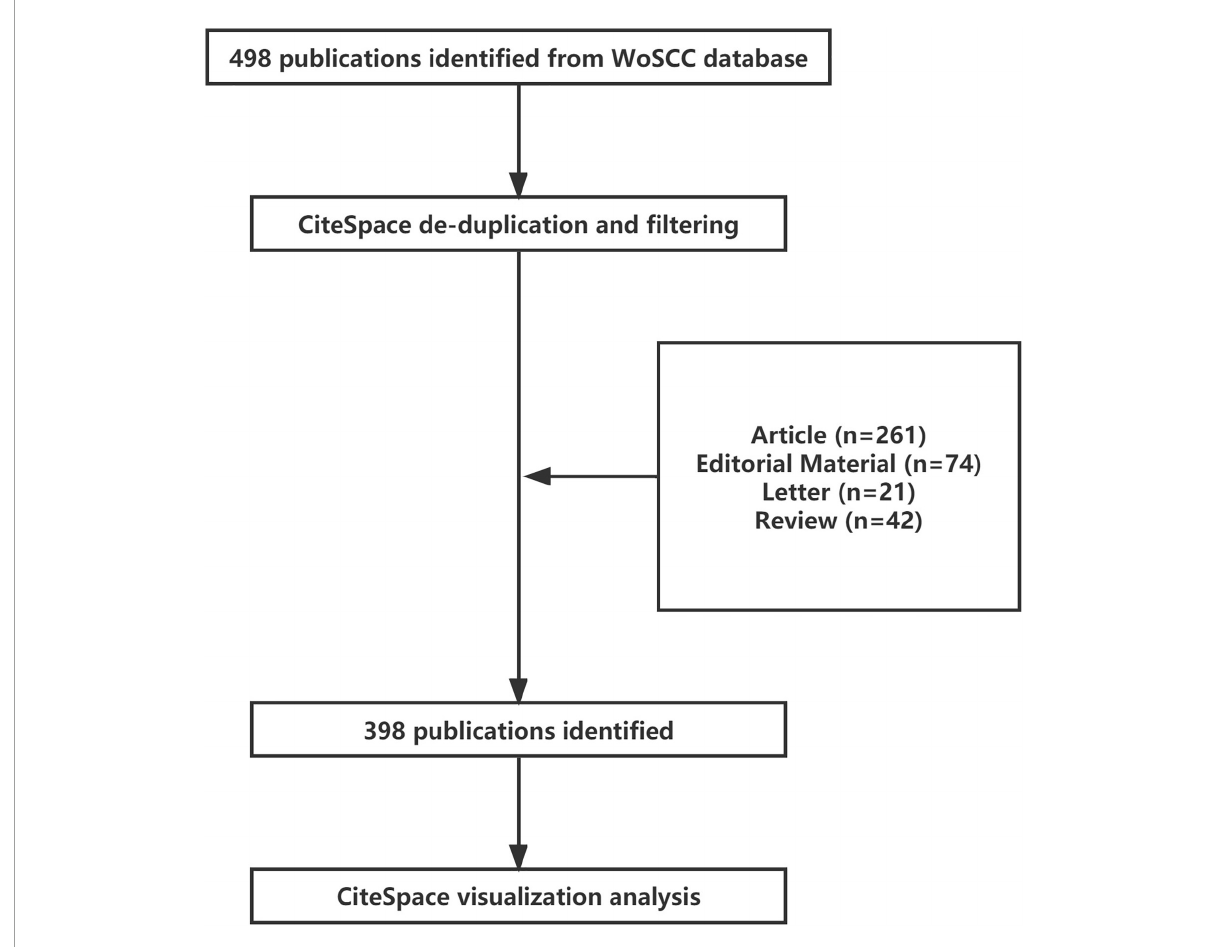
FIGURE2 Flowchart of the screening